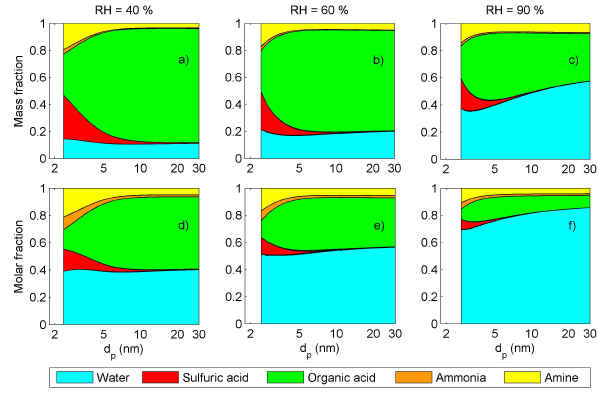
Fig. 6. Dry mass fraction of salts at particle sizes (a) 3nm, (b) 7nm and (c) 20nm as a function of ammonia concentration for three amine concentrations. Concentration and saturation vapour pressure of organic acid were set to 3 × 10 8 cm − 3 and 10 − 6 Pa, respectively. Other properties of organic acid were as for organic acid 1 (Table 1). Sulfuric acid concentration (10 6 cm − 3 ) , RH (40%) and tempera- ture (283.15K) were set to base case values in all simulations (Ta- ble 2).